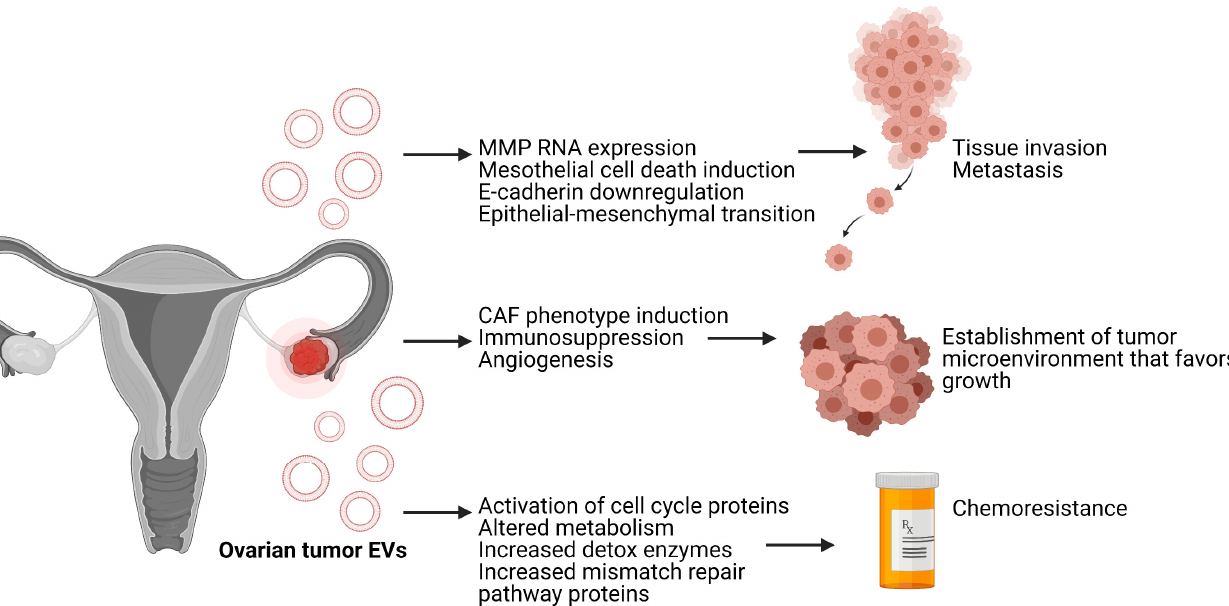
Figure 2. Mechanisms of invasion, growth, and chemoresistance in ovarian cancer mediated by tumor-derived extracellu- lar vesicles.